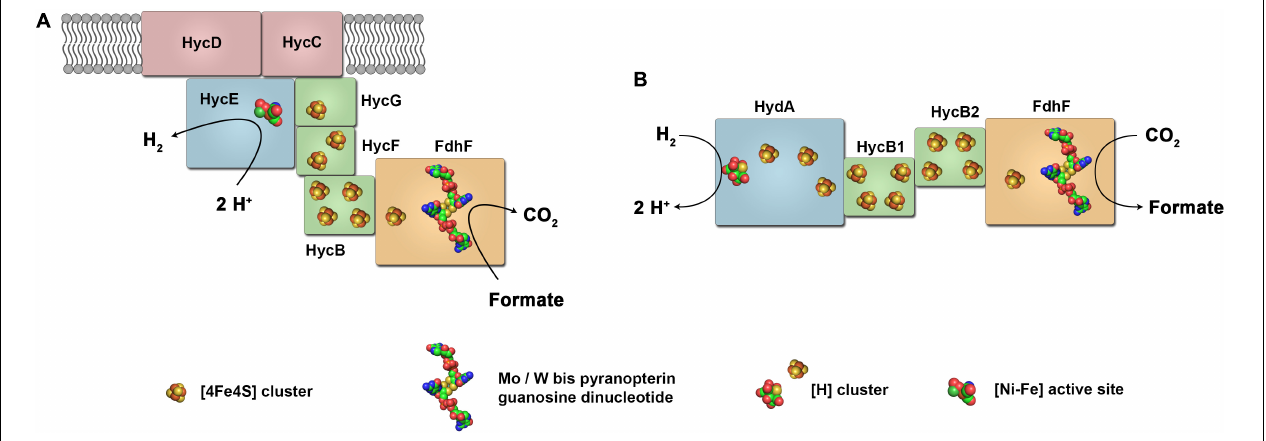
FIGURE 6 | Model of the structure of formate dehydrogenase coupled hydrogenases. FHL of E. coli (A) has the physiological function of formate oxidation coupled to H 2 formation. The FHL consist of a [NiFe] hydrogenase coupled to a formate dehydrogenase and membrane integral subunits. In contrast, the HDCR of A. woodii (B) is composed of a [FeFe] hydrogenase coupled to a formate dehydrogenase and catalyzes reversible CO 2 reduction with H 2 as electron